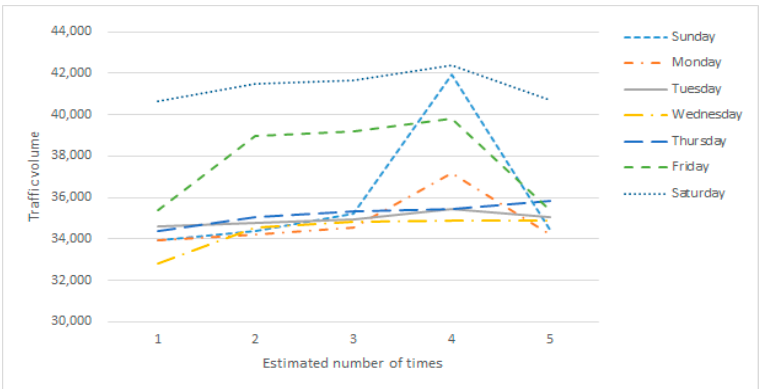
Figure 10. Estimated volume of each weekly traffic.